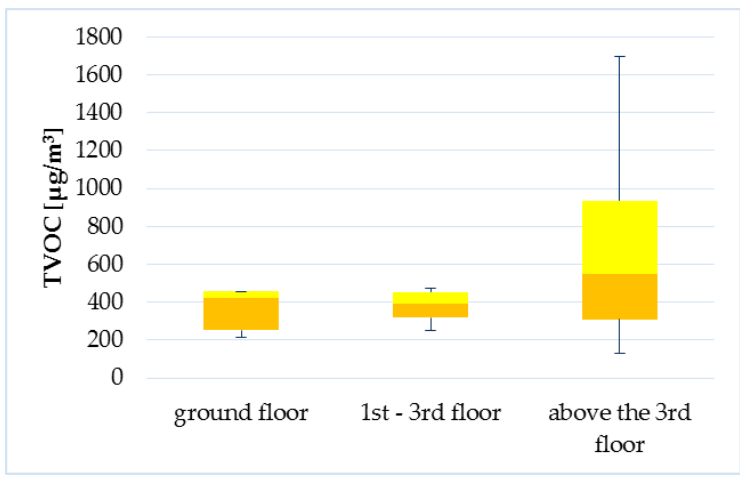
Figure 23. Boxplot of total medians—floor of the apartments.